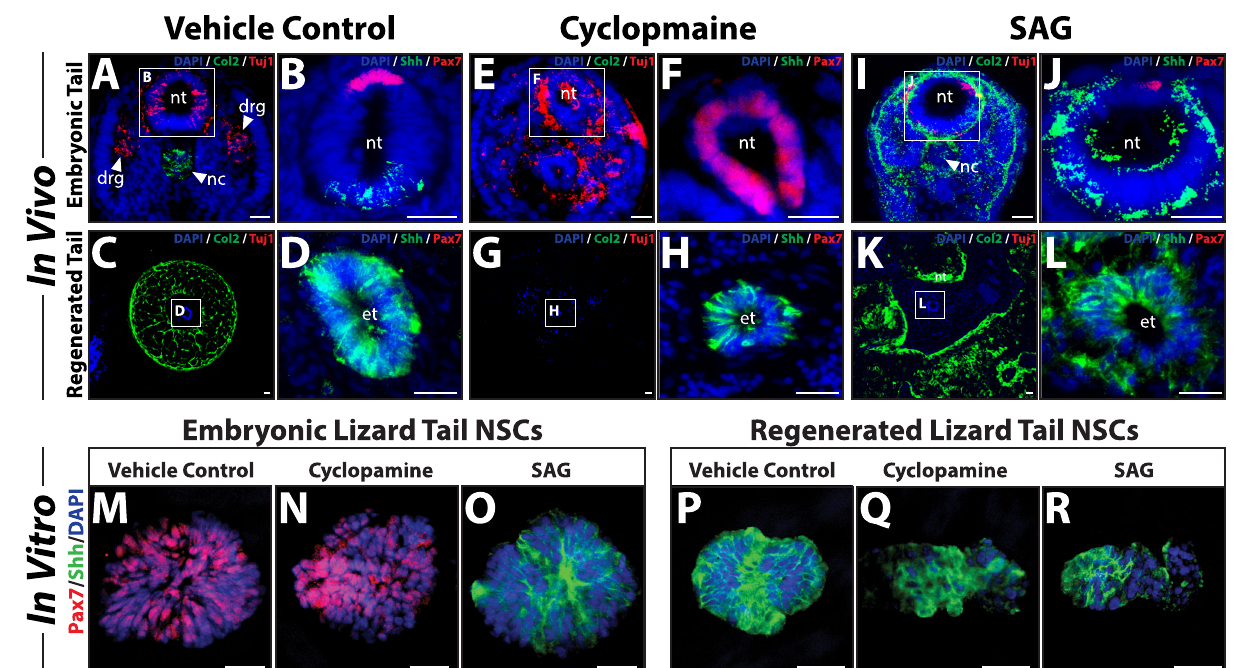
Fig. 3 Hedgehog signaling regulates dorsoventral patterning of embryonic lizard tail NSCs but not regenerated tail NSCs, in vivo and in vitro. A – L Cross sections of embryonic and regenerated lizard tails following treatment with vehicle control, cyclopamine, or SAG were analyzed by Col2 and Tuj1 or Pax7 and Shh IF. Neural and ependymal tube regions enclosed in white boxes are shown in magni fi ed views to the right of the corresponding image. M – R Neurospheres derived from embryonic tail NTs or regenerated tail ETs were treated with vehicle control, cyclopamine (5 µ M), or SAG (100 nM) and analyzed for roof (Pax7) and fl oor (Shh) plate identities via IF. Ten tails and 250 neurospheres belonging to each developmental stage and treatment condition were analyzed. c cartilage, et ependymal tube, nt neural tube. Bar = 50 μ